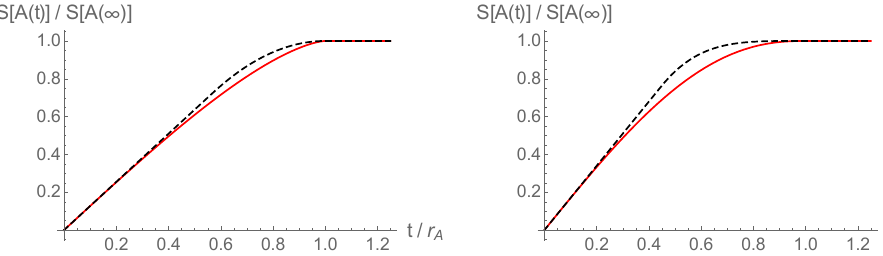
Figure 10 . We plot S [ A ( t )] until saturation for a sphere in the quasiparticle model with EPR pattern of entanglement in d = 3 ; 5 respectively. Black/dashed is the upper bound (3.3) using the quasiparticle value of v E = 2 ; 4 and with v LC set to c , and red/solid is the quasiparticle result (cid:25) 3 (cid:25)